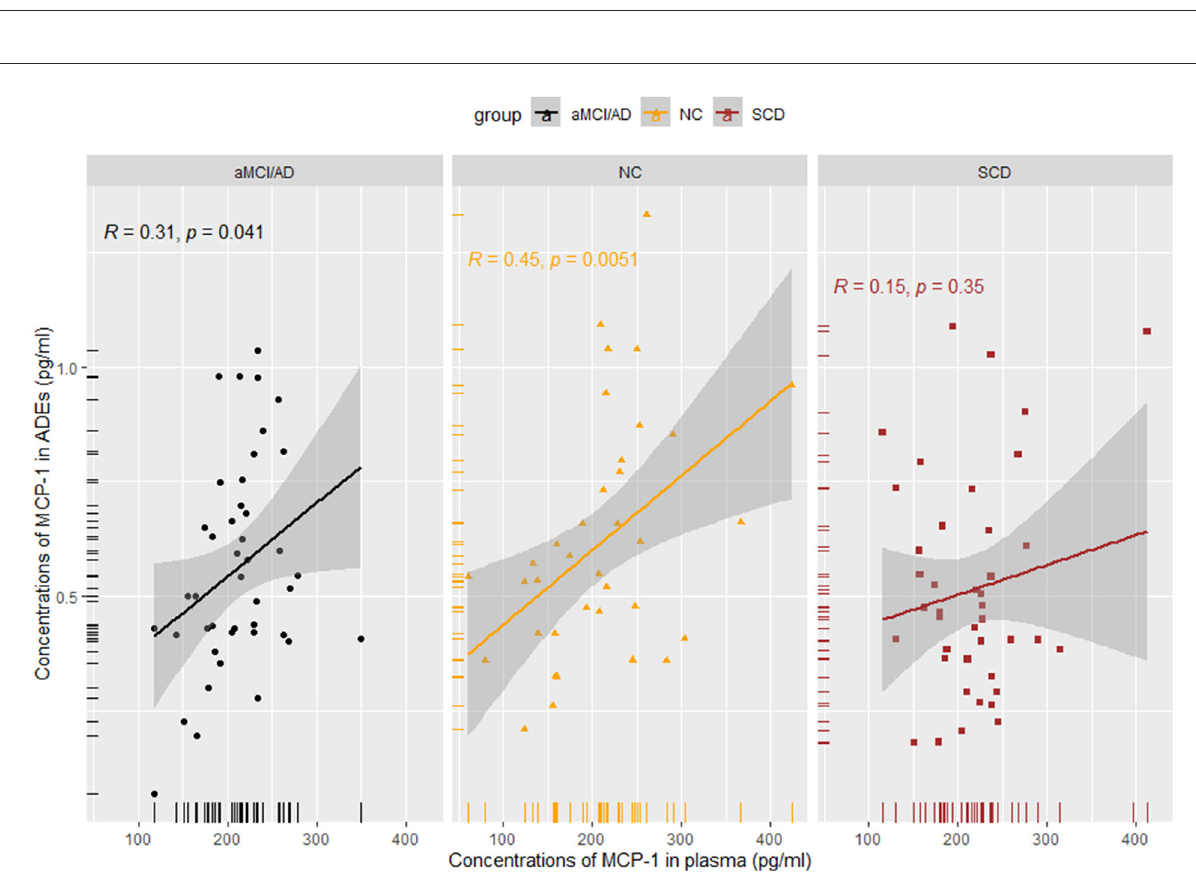
FIGURE4 Spearman rank correlation scatterplots between MCP-1 in plasma and MCP-1 in ADEs in different groups. A weaker correlation was obtained in the SCD and aMCI/AD groups (SCD: R = 0.15, p = 0.35; aMCI/AD: R = 0.31, p =